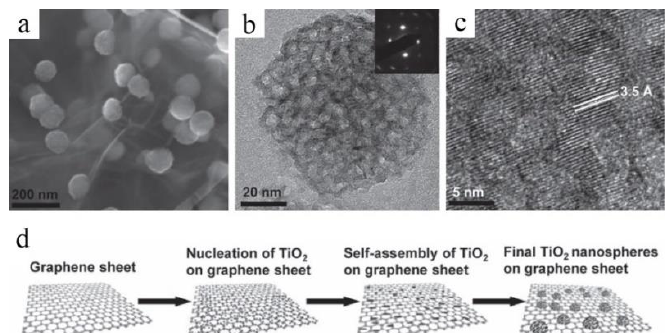
Figure 5. ( a ) SEM, ( b ) TEM, and ( c ) HRTEM images of mesoporous anatase TiO 2 nanospheres on graphene nanosheets. The inset is the SAED pattern related to a single nanosphere; ( d ) Schematic illustration of the growth mechanism of mesoporous anatase nanospheres. Reprinted with permission from [156]. Copyright John Wiley & Sons Inc., 2011.